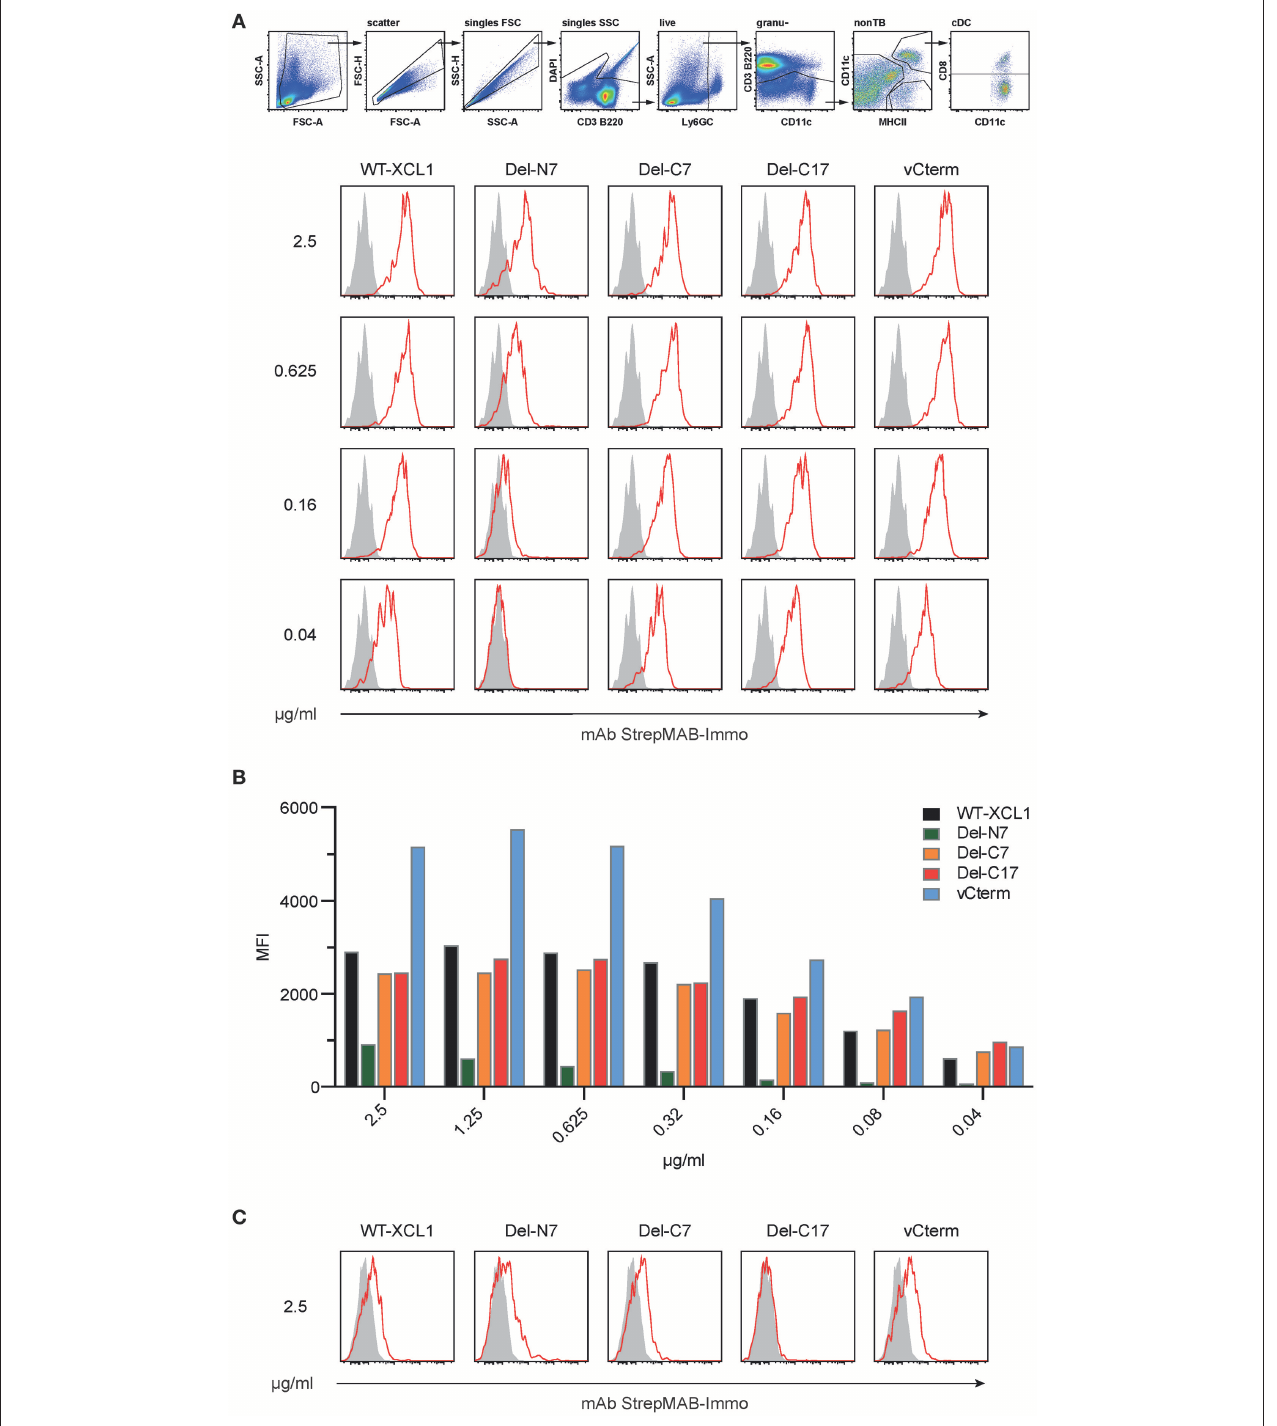
FIGURE 2 | Binding of XCL1 and the structural variants Del-N7, Del-C7, Del-C17, and vCterm to XCR1 expressed on primary dendritic cells . Splenocytes were incubated with carefully titrated (0.04, 0.08, 0.16, 0.315, 0.625, 1.25, and 2.5 µ g/ml) concentrations of all XCL1-OVA protein variants (all concentrations are given based on the XCL1-component of the constructs) for 25min on ice, washed, and the bound protein was detected on Ly6G/C − CD3 − B220 − CD8 + CD11c + MHC-II + cells using an anti-Strep-tag mAb StrepMAB-Immo and flow cytometry (red histograms). Background staining, without pre-incubation, using StrepMAB-Immo is shown in gray. (A) Signals obtained with XCL1-variants at 0.04, 0.16, 0.625, and 2.5 µ g/ml. (B) Graphical representation of the mean fluorescence intensity (MFI) obtained in flow cytometry with all protein concentrations of the XCL1-OVA variants used. (C) Signals (shown for 0.625 and 2.5/ µ g/ml) obtained on CD8 + DC lacking XCR1. Data are representative of 3 independent